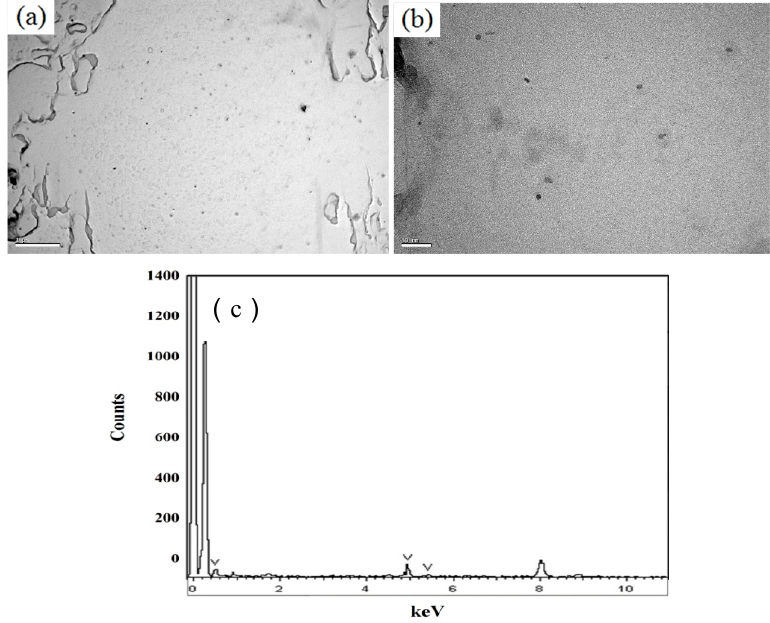
Figure 6. TEM observation of 0.052%V TAM steel: ( a ) Microstructure, ( b ) Precipitate, ( c ) Energy Dispersive Spectrometer (EDS) result indicating V precipitates.